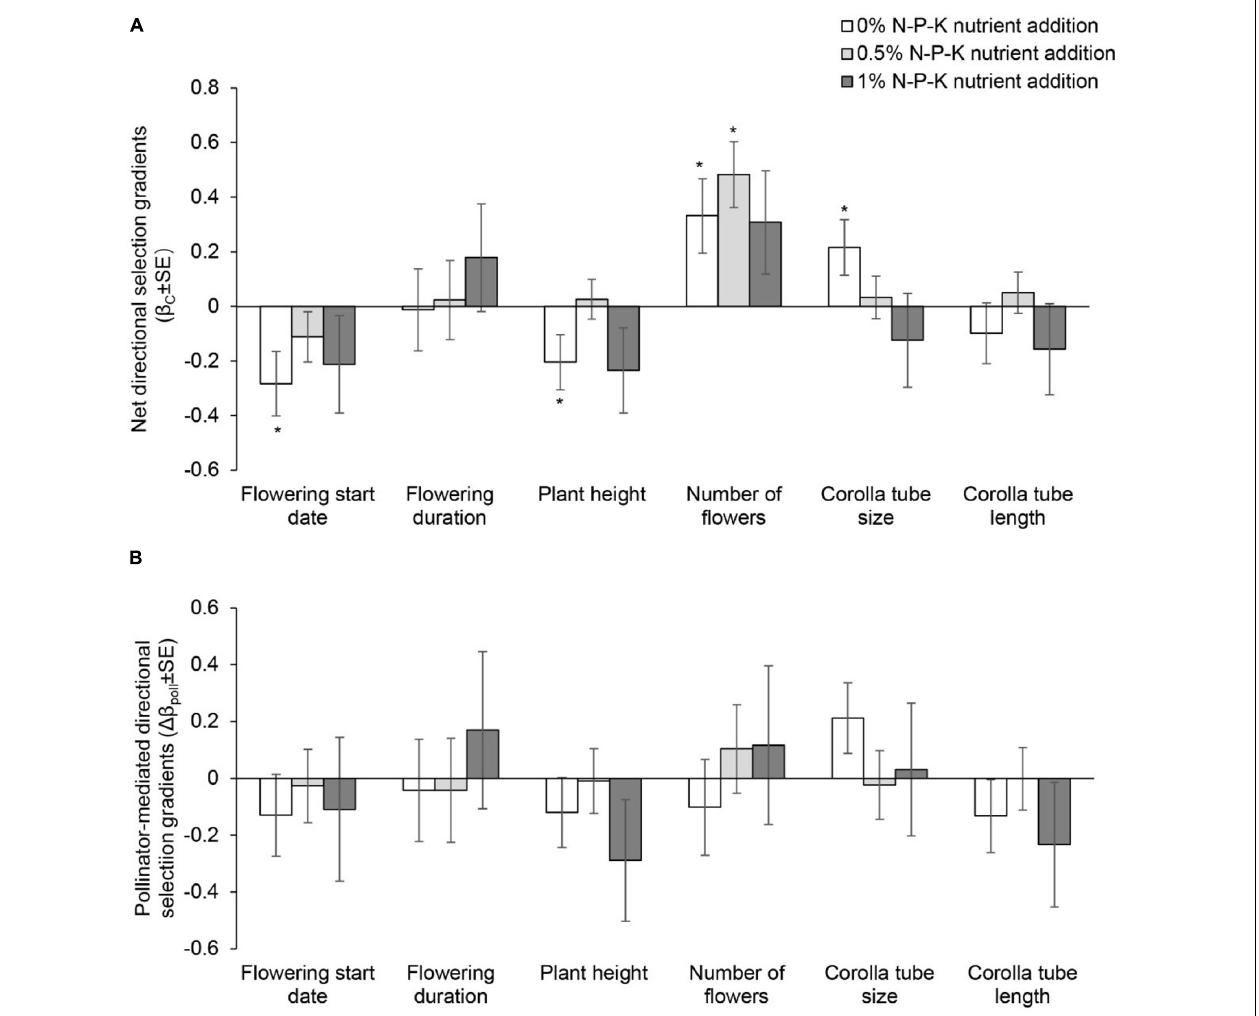
FIGURE 4 | Net directional selection gradients (A) and pollinator-mediated selection gradients (B) on flowering start date, flowering duration, plant height, number of flowers, and corolla tube size and length in Primula tibetica among nutrient addition treatments. The symbols above the individual bars indicate the level of significance of the selection gradient. Net selection and pollinator-mediated selection on floral traits did not vary among nutrient addition treatments ( P > 0.05; Supplementary Tables 14, 15 ). * P <